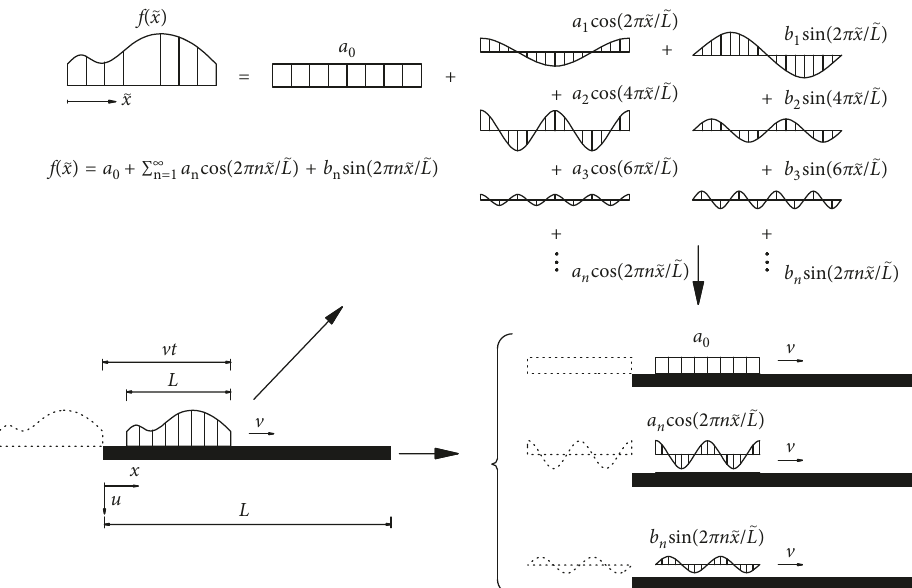
Figure 1: A single-span beam subjected to a moving distributed force and its equivalent